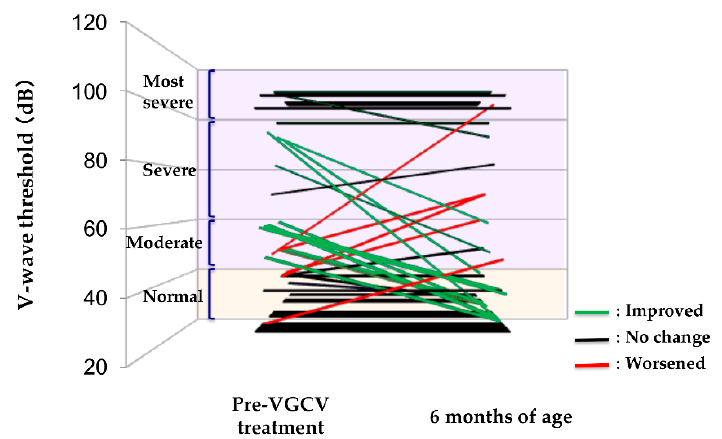
Figure 1. Efficacy of V-wave threshold after VGCV treatment. VGCV, valganciclovir.